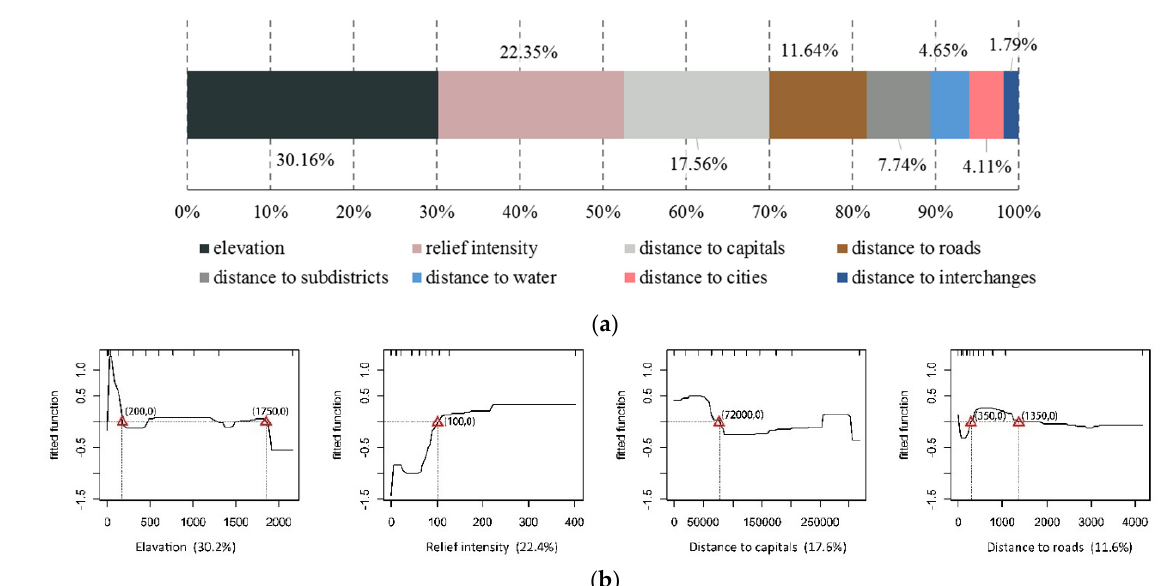
Figure 13. Factor contribution ranking and marginal effect of PS–ES. ( a ) Contribution degree of factors; ( b ) marginal effect of factor with a contribution degree over 10%.